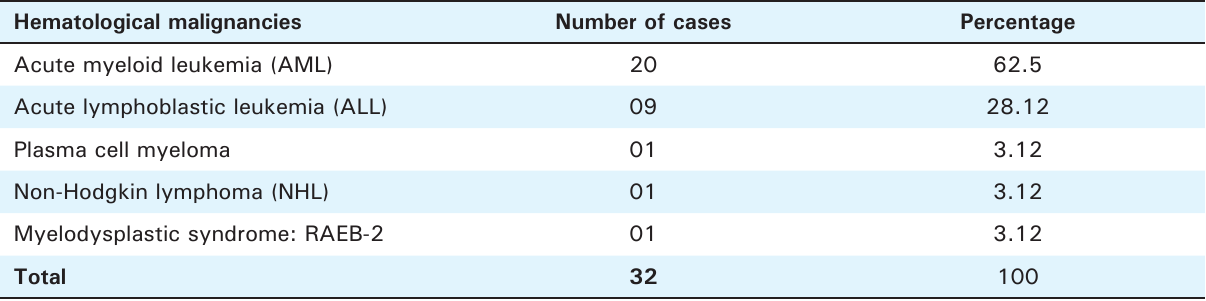
Table 2. Hematological malignancies in cases of pancytopenia